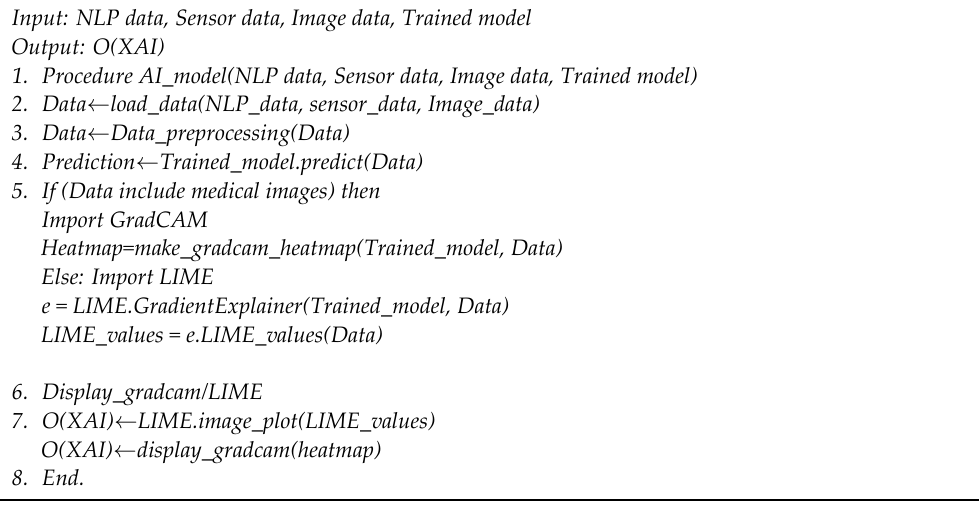
Algorithm 1: Artificial‑intelligence‑based model for the healthcare metaverse